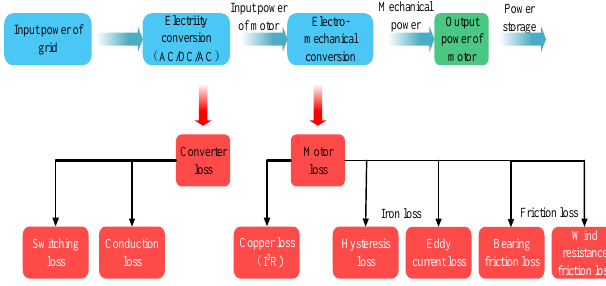
Figure 1. Energy conversion during flywheel charging.